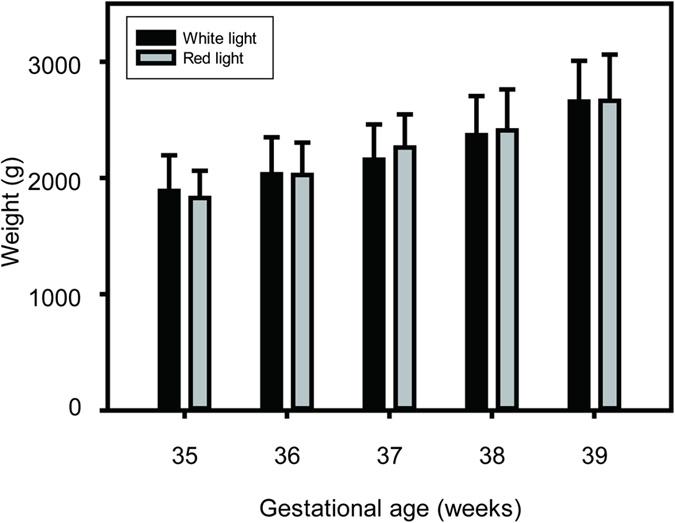
Body weight gains over consecutive 7-day periods, at 35, 36, 37, 38, and 39 weeks of gestational age (WGA).Dark bars: control infants exposed to white LED light during night; gray bars: experimental group infants exposed to red LED light during night (mean ± s.d.). Observe that exposure to white or red LED lighting results in similar weight gains over each range of days.